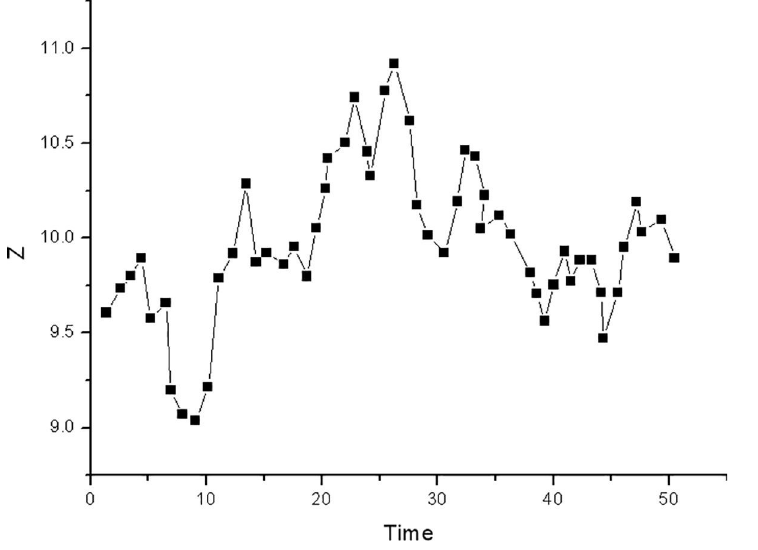
Fig 1. Basic Wiener